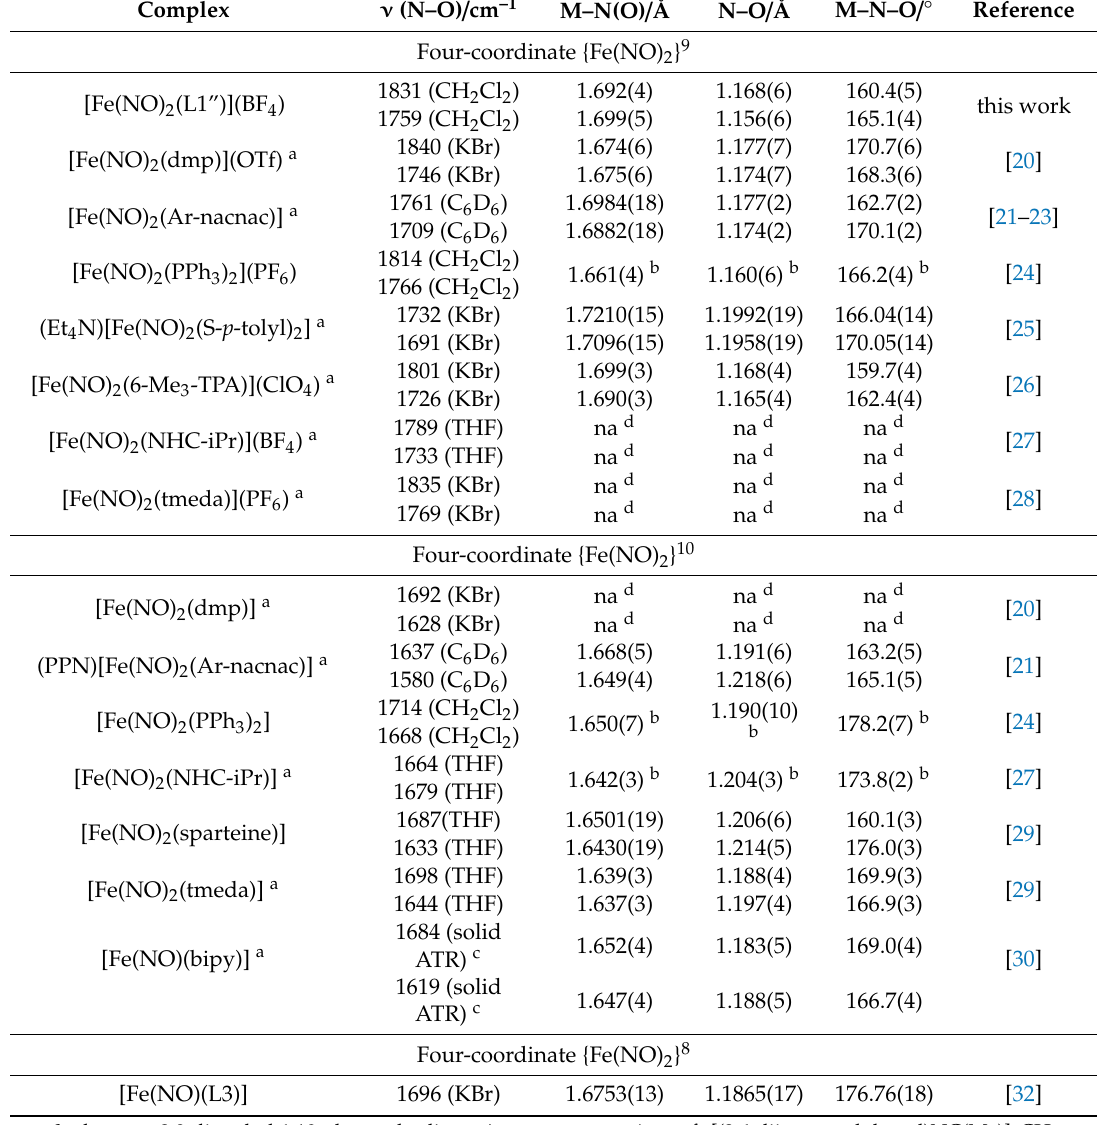
Table 1. Structuralparametersofselected{Fe(NO) 2 } 9 and{Fe(NO) 2 } 10 DNICsandtherelated{FeNO} 8